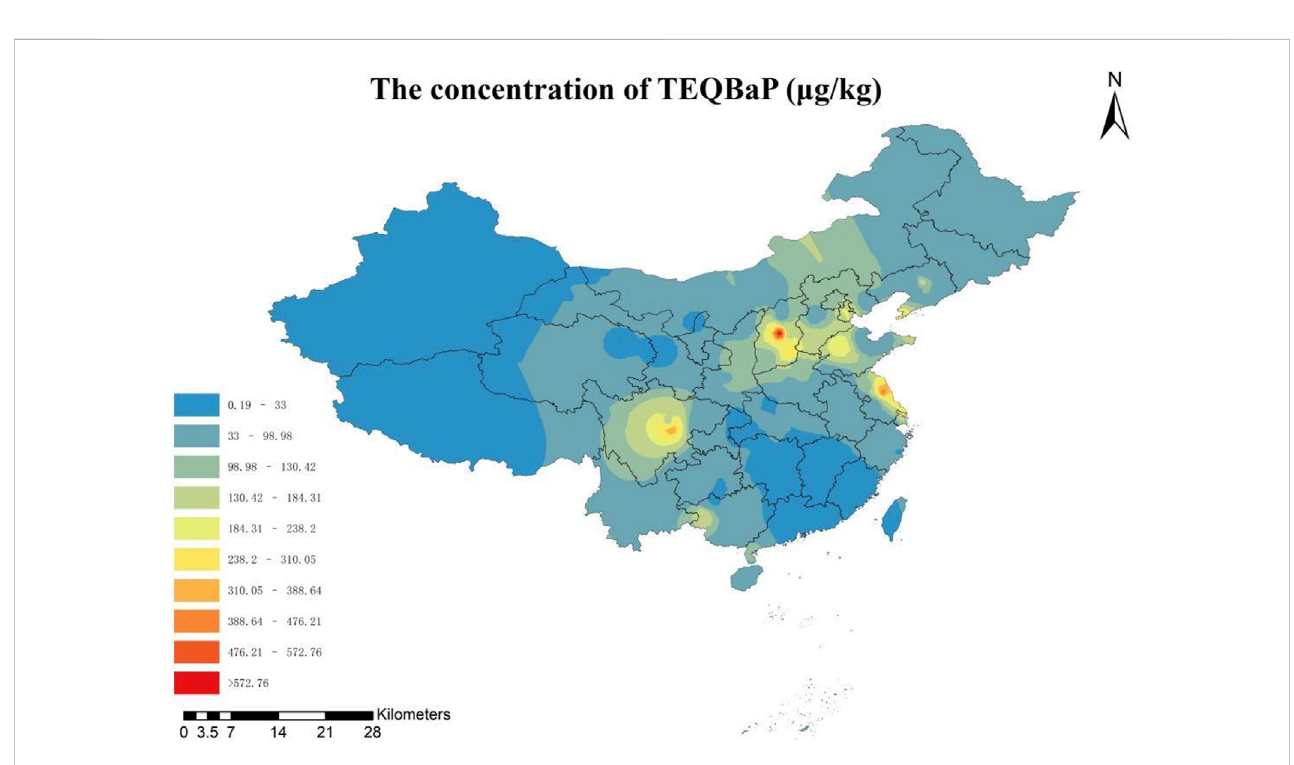
The spatial distribution of TEQ BaP in China from collected